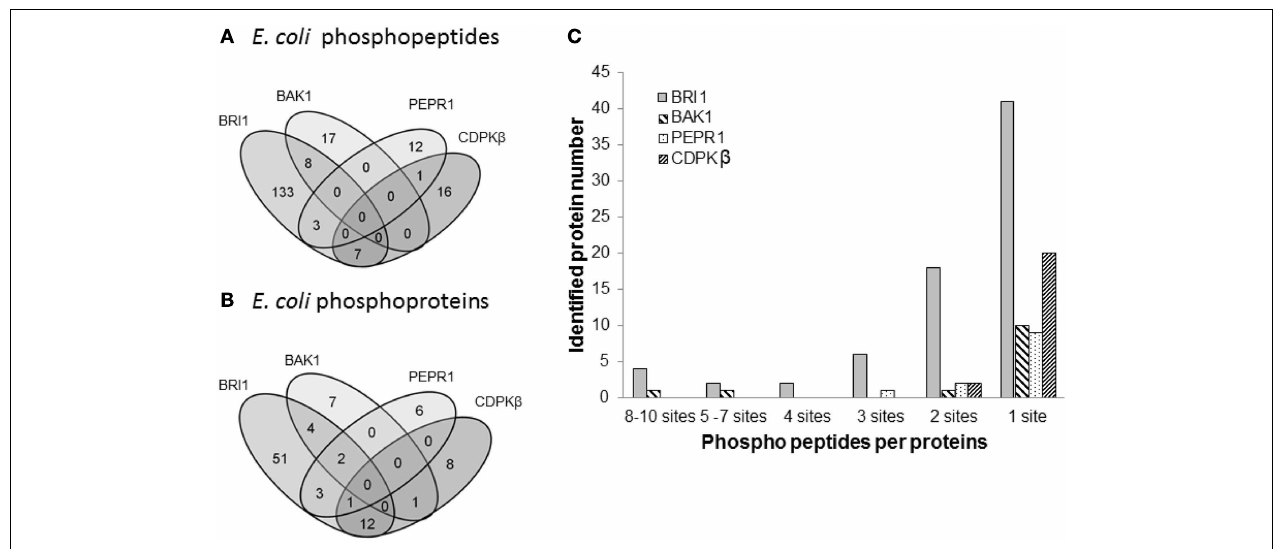
the four kinases expressed individually in E. coli . (C) Number of phosphosites per protein that were identified following expression of the protein